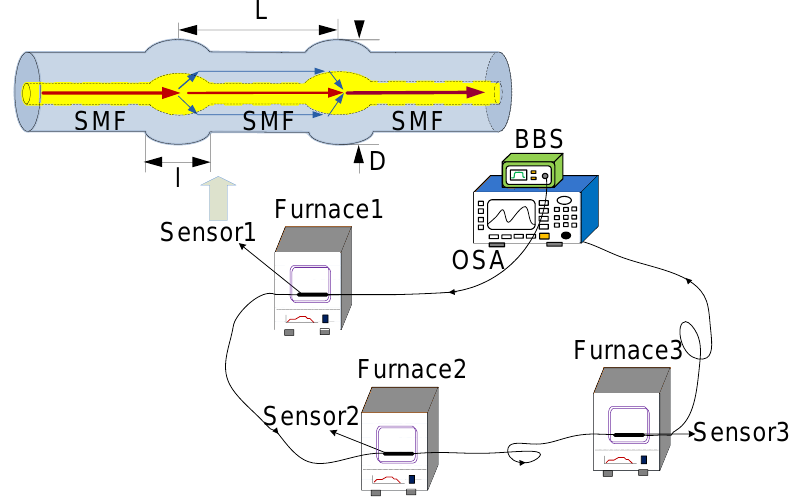
Figure 1. A schematic diagram of the temperature measurement experiment system, and the structure of a sensor used for temperature measurement is magnified.